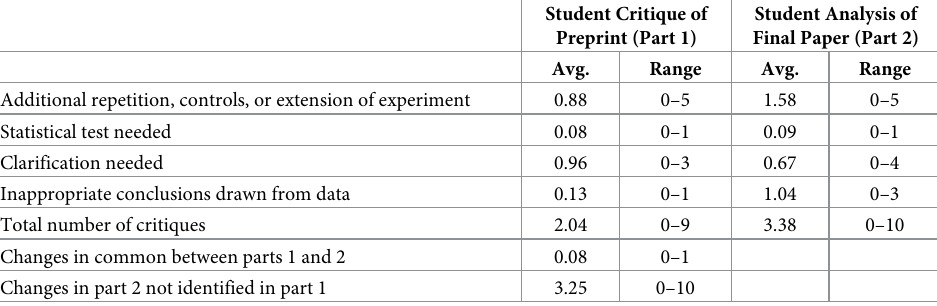
Table 1. Suggested and actual changes between preprint and final